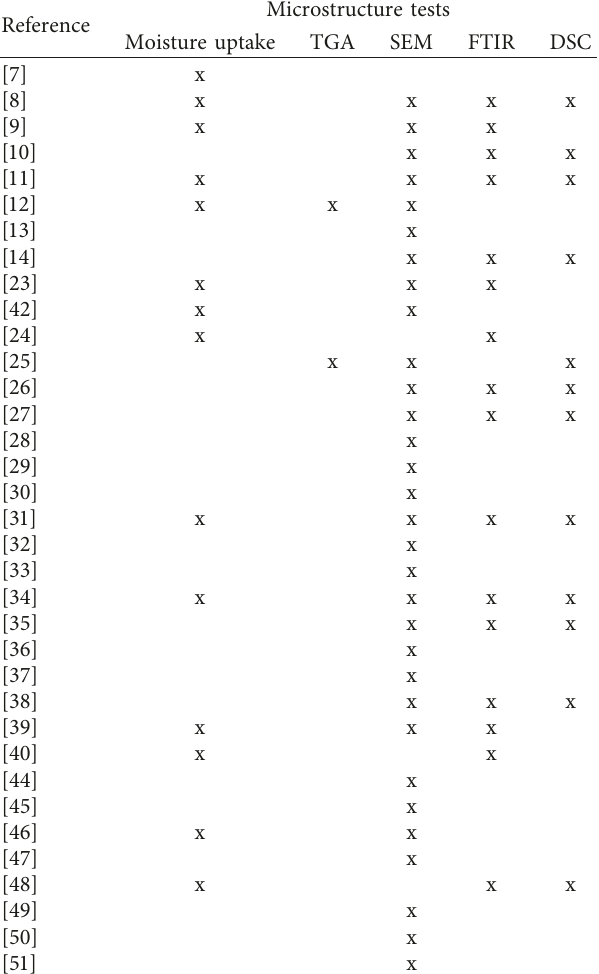
Table 7: Summary of microstructure tests conducted on GFRP reinforcing bars.